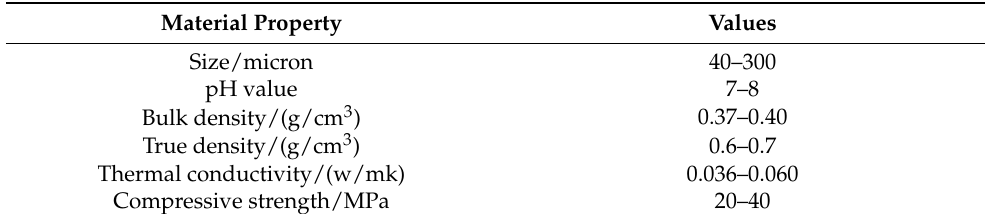
Table 2. Material characteristics of FAC used in the experiments.